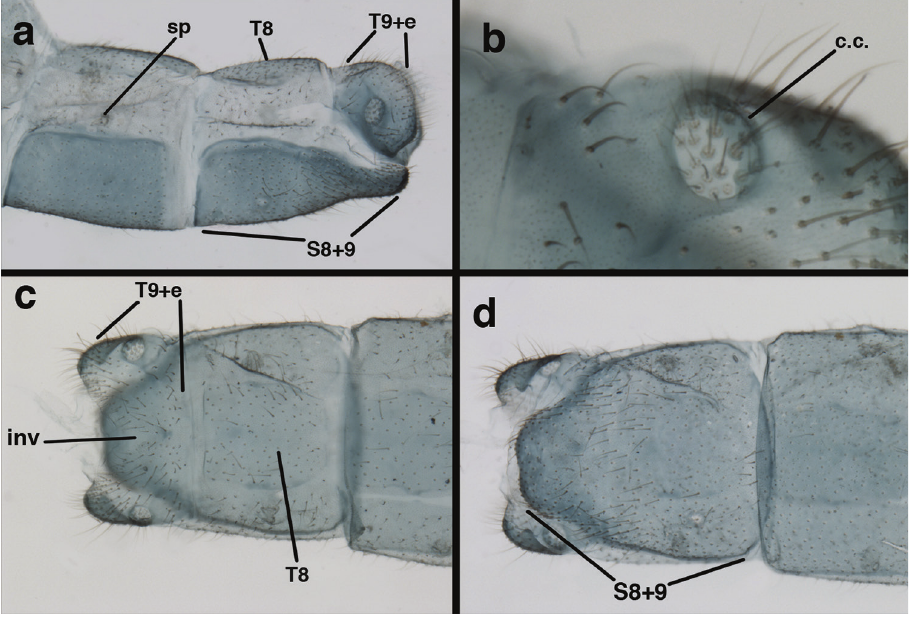
Figure 33. Ungla diazi Sosa: Male abdomen, ( a ) segments A7-terminus, lateral ( b ) callus cerci ( c ) eighth tergite and ninth tergite + ectoproct, dorsal ( d ) fused eighth and ninth sternites, ventral. c.c. cal- lus cerci inv invaginated dorsal cleft in T9+ectoproct sp spiracle S8+9 fused eighth and ninth sternites T8 eighth tergite T9+e fused ninth tergite and ectoproct (all: Bolivia, Cochabamba,